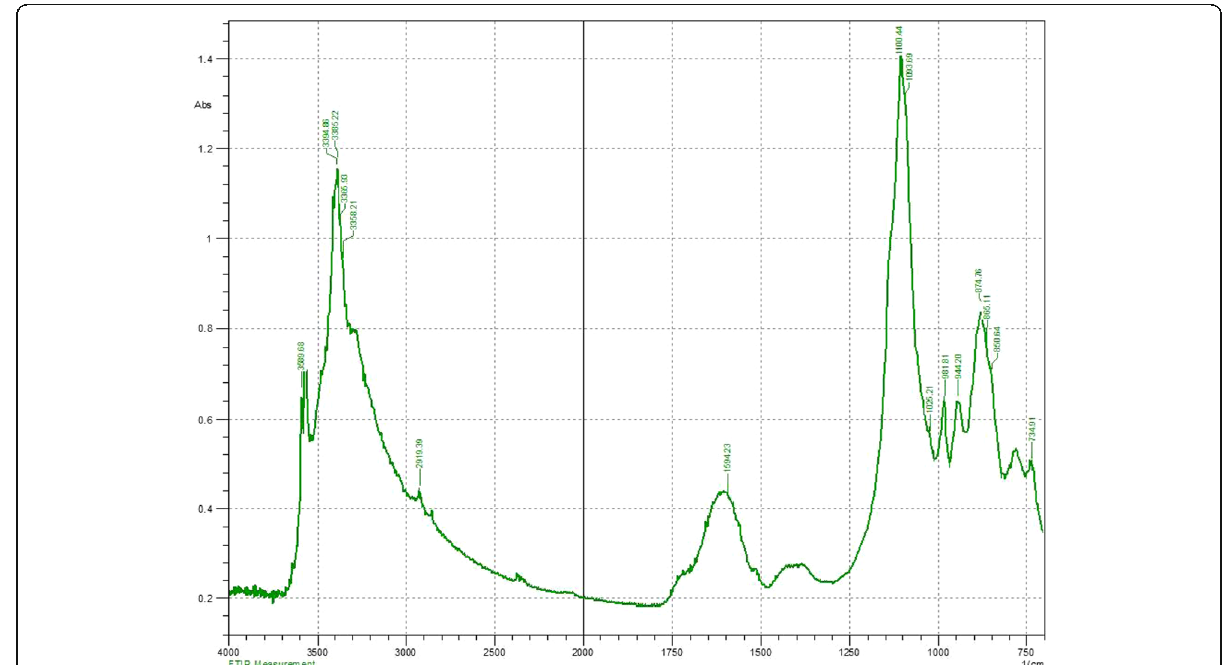
Fig. 2 FTIR analysis of nano hybrid particles